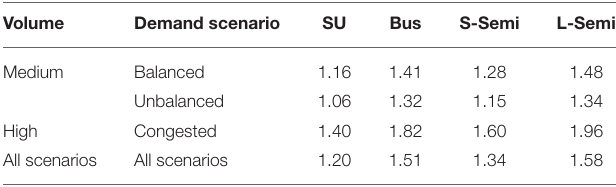
TABLE 3 | Estimated PCE values for three demand scenarios and all scenarios for HCM method.